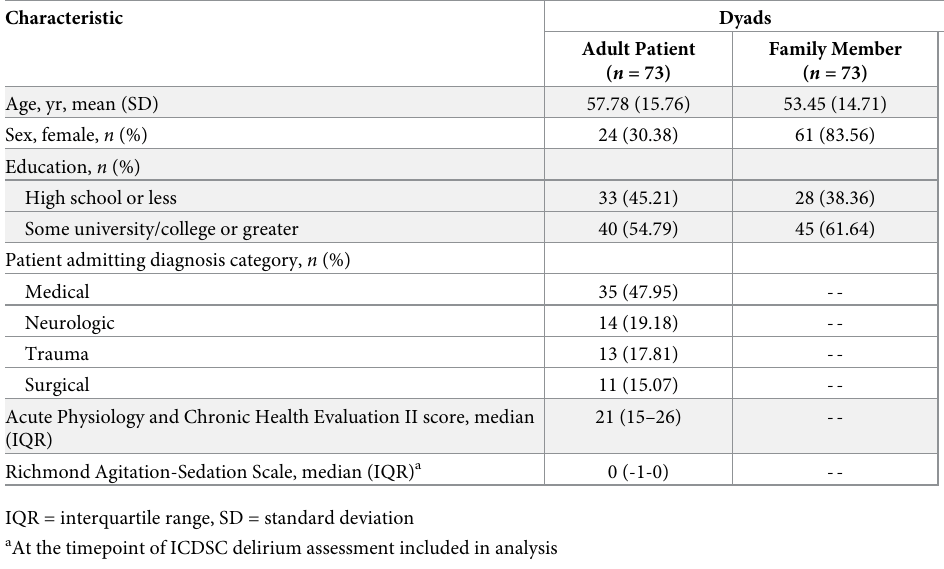
Table 1. Demographic and clinical characteristics of 73 included patients and family members. Characteristic Dyads